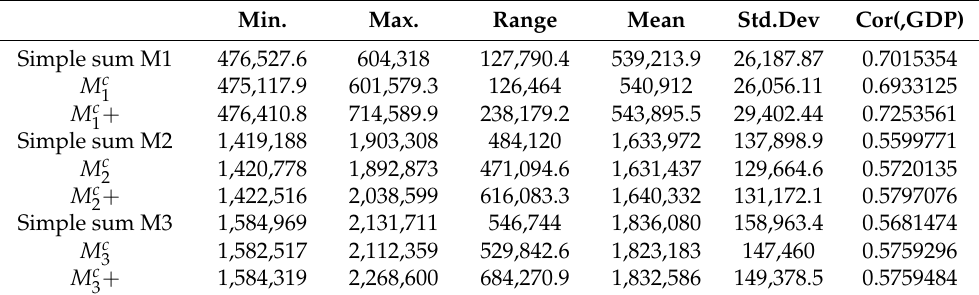
Table 2. Basic statistics for different consumption loan augmented monetary aggregates. Min. Max. Range Mean Std.Dev